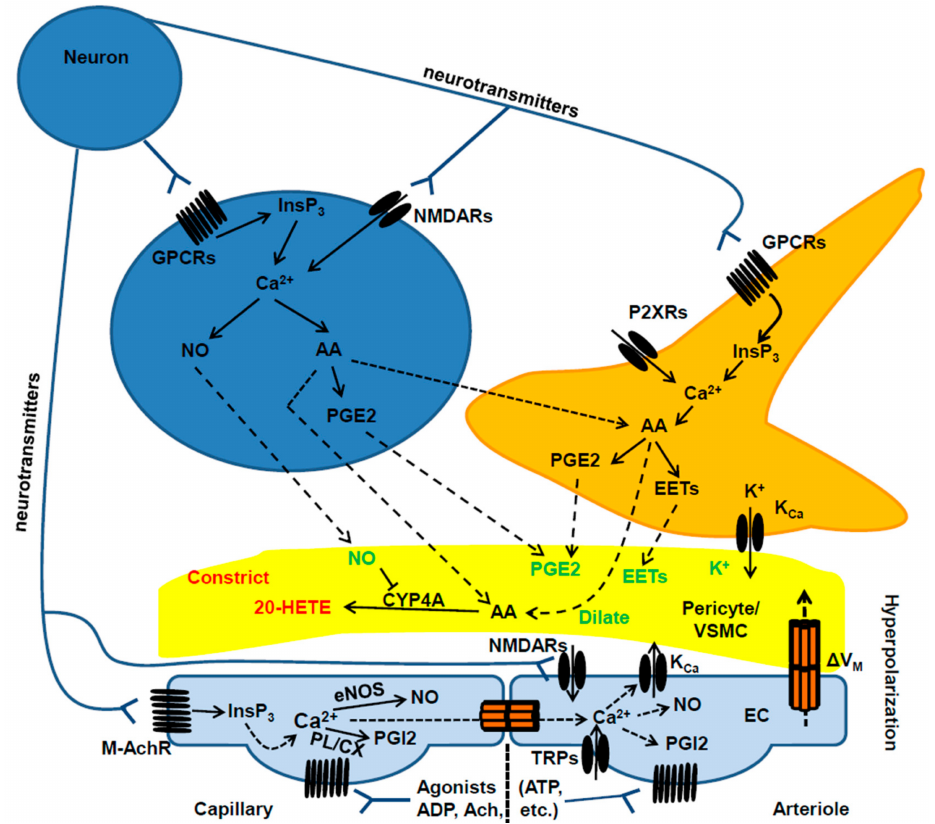
Figure 5. The putative role of endothelial Ca 2+ signaling in neurovascular coupling. Synaptic activity leads to arteriole and capillary vasodilation by inducing an increase in [Ca 2+ ] i in postsynaptic neurons and perisynaptic astrocytes, as shown in Figure 2. Recent evidence indicated that synaptically-released glutamate may activate endothelial NMDARs, thereby eliciting the Ca 2+ -dependent activation of eNOS, in intraparenchymal arterioles. Moreover, acetylcholine may induce Ca 2+ -dependent NO release from brain endothelial cells by initiating the concerted interplay between InsP 3 Rs and SOCE [76]. This local vasodilation may be spread to more remote sites ( ≈ 500 µ m) through the initiation of an interendothelial Ca 2+ wave, which ignites NO release and PGI2 production as long as it travels along the endothelial monolayer. Moreover, this propagating Ca 2+ sweep could induce vasodilation by also stimulating K Ca channels and evoking EDH in arterioles. Finally, blood-borne autacoids and dietary agonists could induce vasodilation by, respectively, binding to their specific GPCRs and stimulating multiple TRP channels (TRPC3, TRPV3, TRPV4, TRPA1) to initiate EDH. Abbreviations: 20-HETE: 20-hydroxyeicosatetraenoic acid; AA: arachidonic acid; CX: cyclooxygenases 1 and 2; EETs: epoxyeicosatrienoic acids; GPCRs; G-protein-coupled receptors; InsP 3 : inositol-1,4,5-trisphosphate; K Ca : Ca 2+ -activated intermediate and small conductance K + channels; NO: nitric oxide; nNOS: neuronal NO synthase; P450: cytochrome P450; PGE2: prostaglandin E2; PL: phospholipase A2; PLD2: phospholipase D2; TRPs: TRP channels; VSMC: vascular smooth muscle